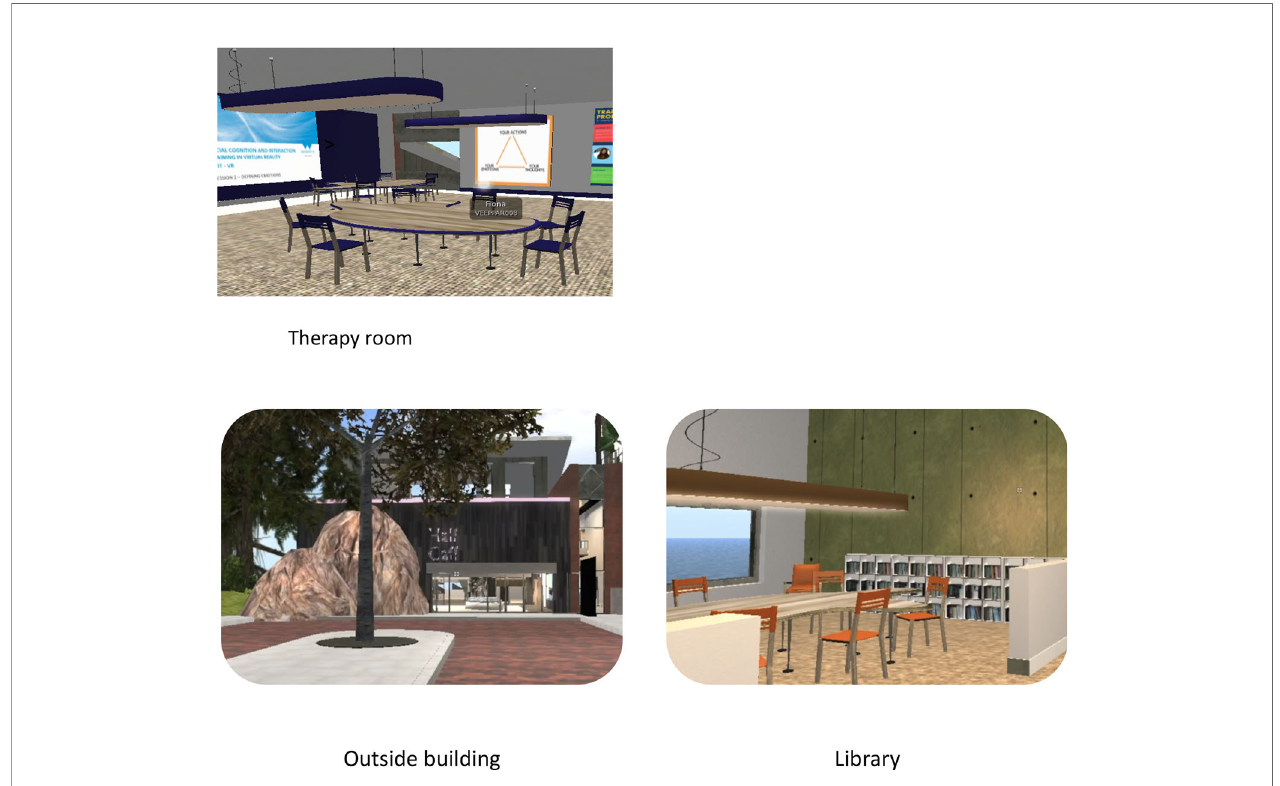
FIGURE 1 | Screenshots of the Second Life© environment adapted from